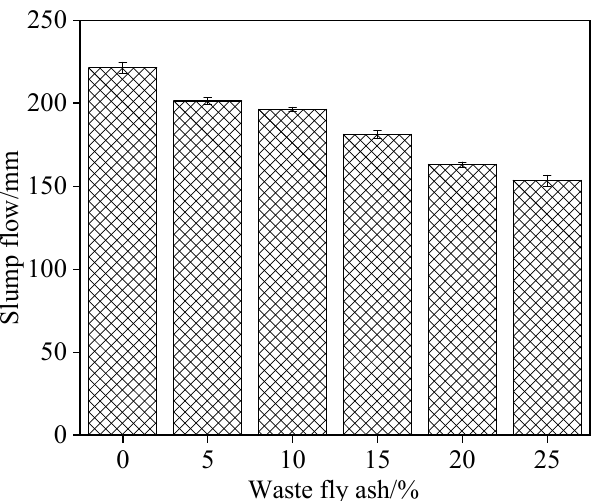
Figure 2. The slump flow of fresh RPC with WFA.